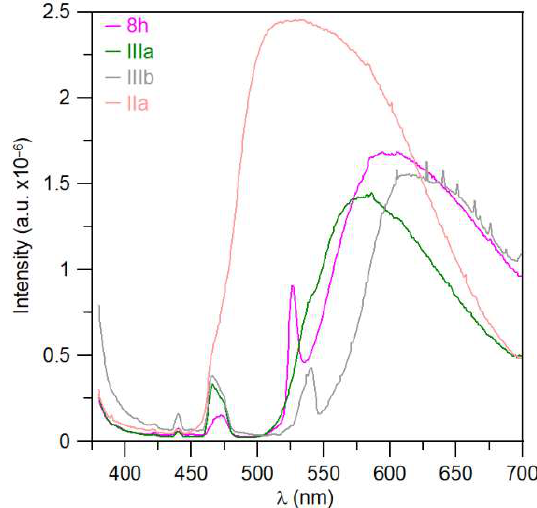
Figure 14. Fluorescence spectra of triazaborine 8h and previously prepared diazaborinone IIa (Scheme 2, R 1 = Me, R 2 = H) and triazaborines IIIa (Scheme 2, R 1 = Me, R 2 = H) and IIIb (Scheme 2, R 1 = Ph, R 2 = Me).